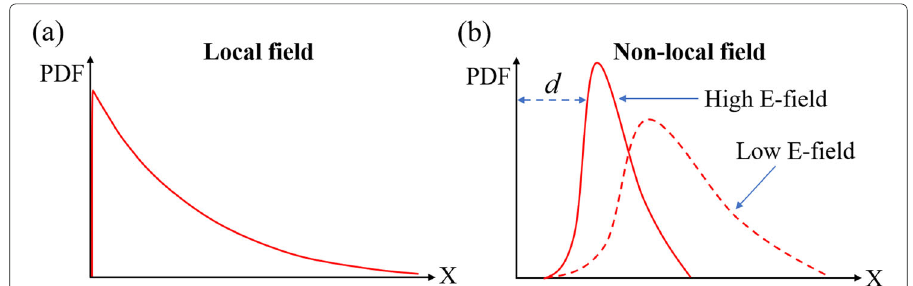
Fig. 3 Probability distribution functions of carrier ionization in a multiplication gain region for a the local field model and b the non-local field model with the dead space for high E-field (solid line) and low E-field (dashed